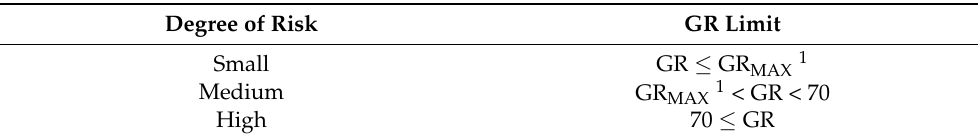
Table 1. Elaborated criteria (based on glare rating (GR)) for the degree of risk arising from glare at outdoor workplaces.